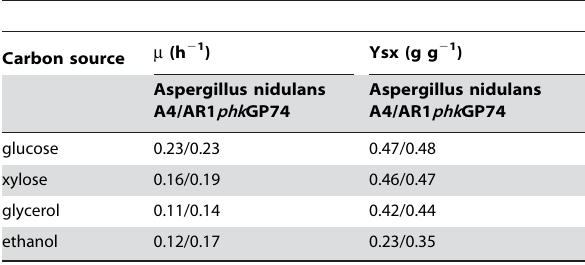
Table 1. Specific growth rates and biomass yields of A. nidulans A4 (wild type) and AR1 phk GP74 (mutant) cultivated in four different carbon